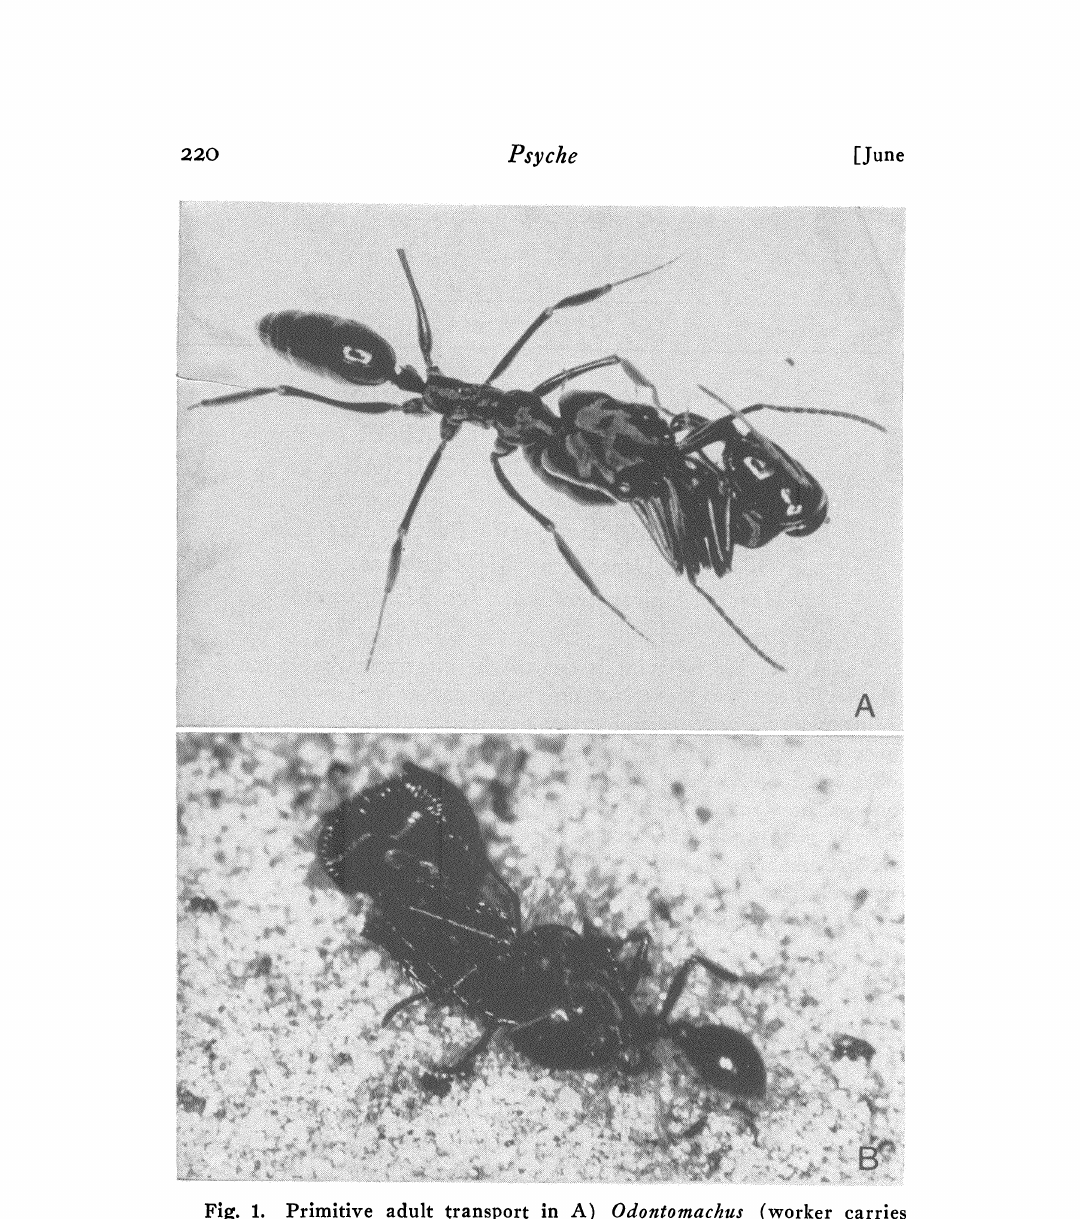
Fig. 1. Primitive adult transport in A) Odontomachus (worker carries worker) B) Pogonomyrmex badius (worker carries "soldier"